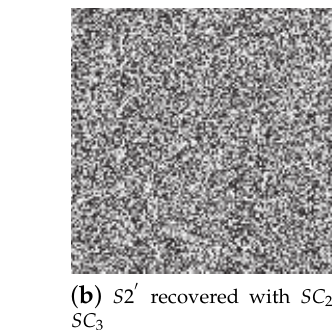
Figure 6. Experimental results of the proposed ( 3,4 ) threshold SIS authentication with dealer-participatory and non-dealer-participatory mutual shadow authentication capabilities, when there is a fake shadow participating in recovery. ( a ) Fake shadow SC ∗ authentication image with the LSB of SC 2 , SC 3 and SC ∗ grayscale secret image S 2 ∗ with SC ∗ , SC 2 and SC 3 .